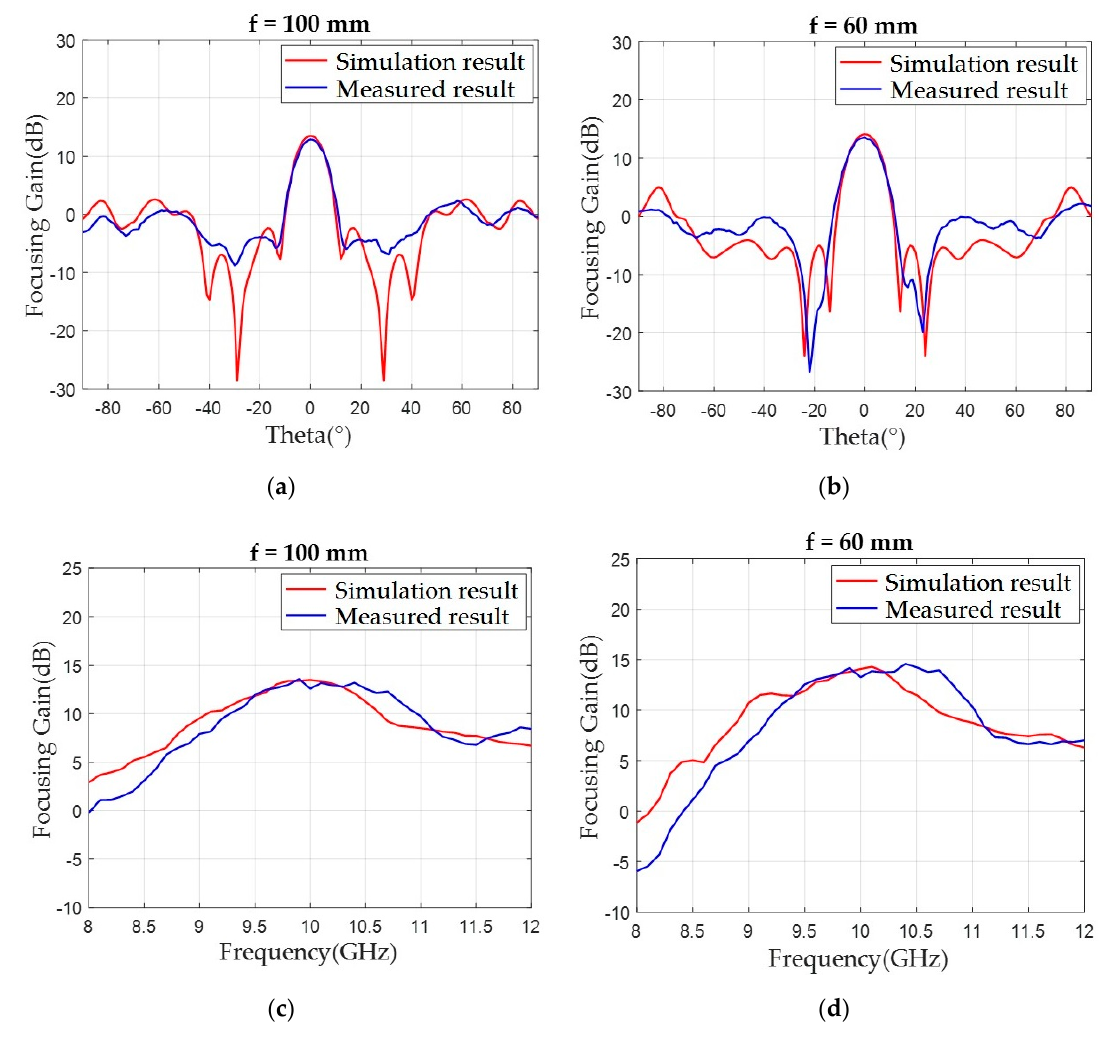
Figure 14. Simulated and measured and focusing gain patterns on the x-z plane with a function of theta at 10 GHz from the focusing lenses ( a ) with f = 100 mm and ( b ) with f = 60 mm. Simulated and measured focusing gain according to frequency from ( c ) f = 100 mm and ( d ) f = 60 mm.